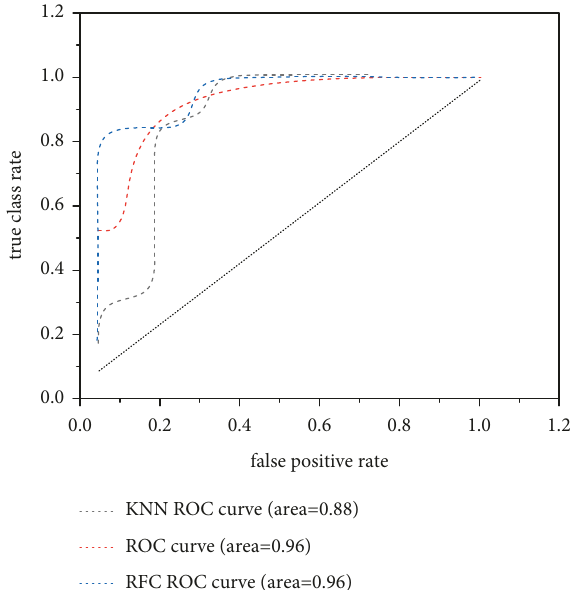
Figure 7: ROC curves of models KNN, LR, and RFC to identify relaxation and low-stress